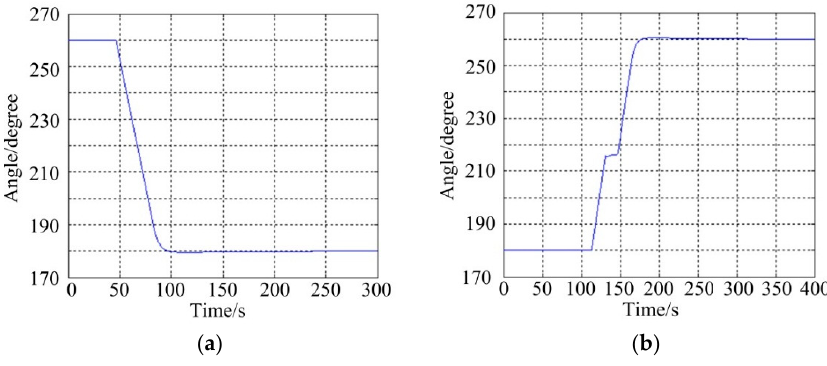
Figure 15. Stabilization results of the azimuth system under static base conditions: ( a ) command angle from 260° to 180°; ( b ) command angle from 180° to 260°.